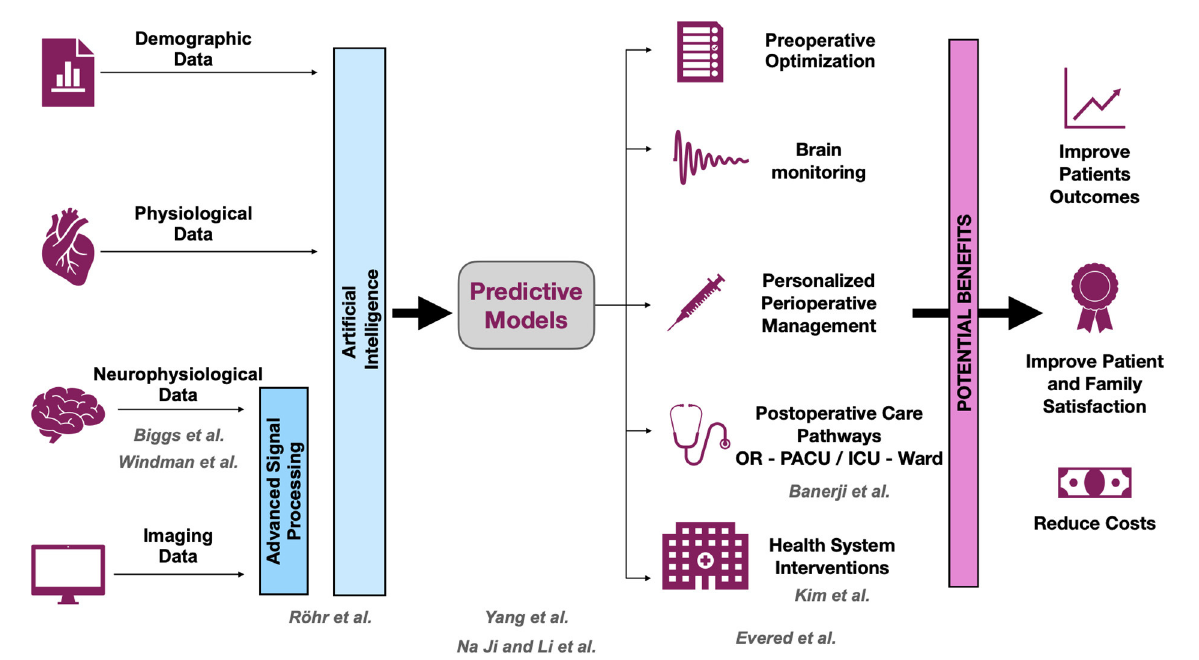
FIGURE1 Opportunities and benefits to improve postoperative neurocognitive disorders (PNDs). The scheme shows how research could help to improve the outcomes associated with PND. The development of predictive models is crucial for planning strategies to mitigate PND. All contributions that are part of this Research Topic cover at least one of the levels, and they are displayed in gray. OR, operating room; PACU, post-anesthesia care unit; ICU, intensive care